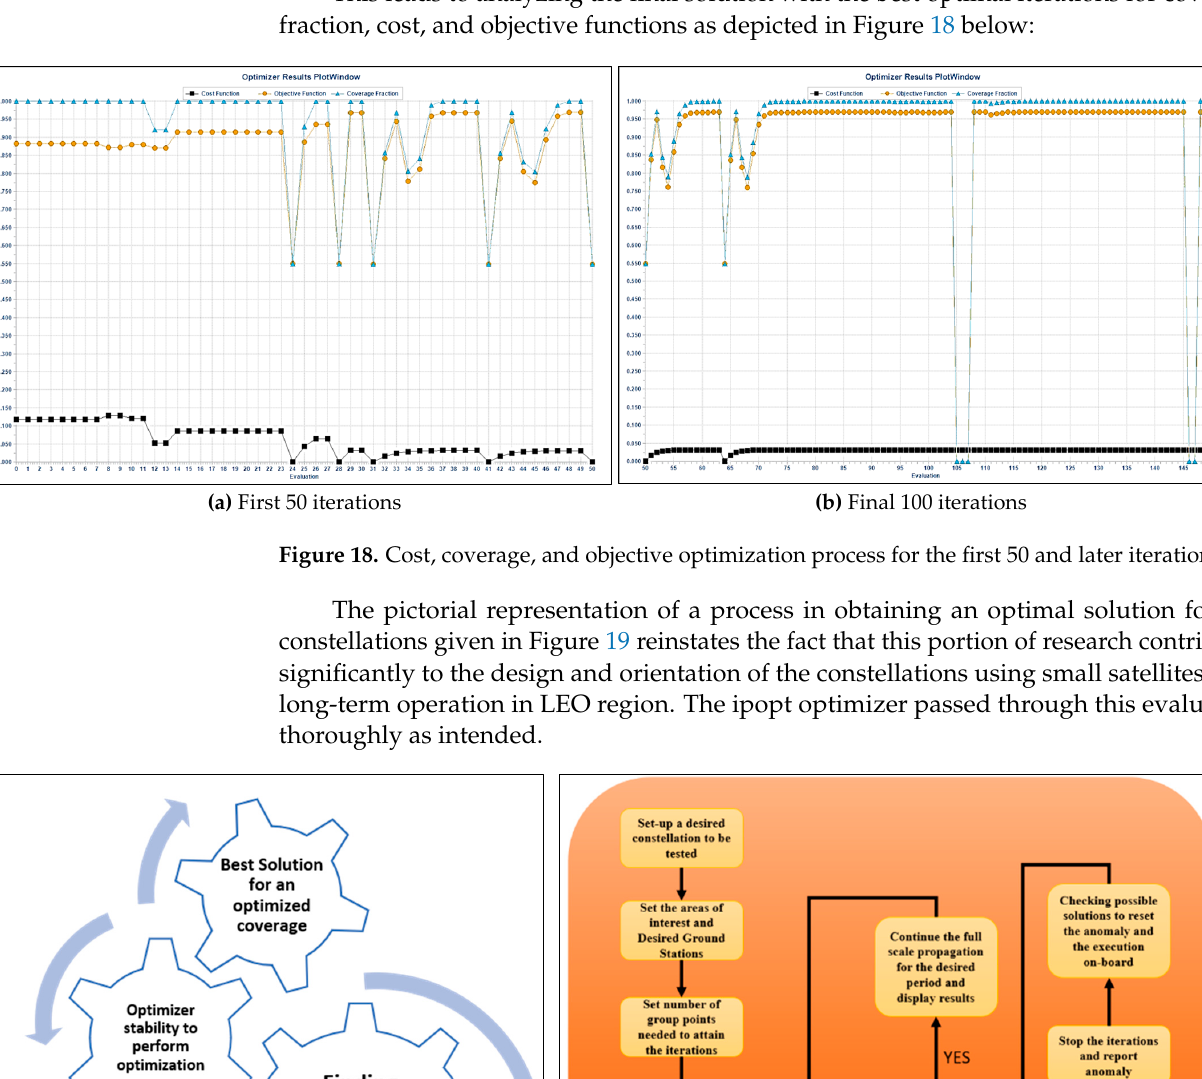
Table 2. Best solution for full coverage of small satellite constellation with the ipopt optimizer.